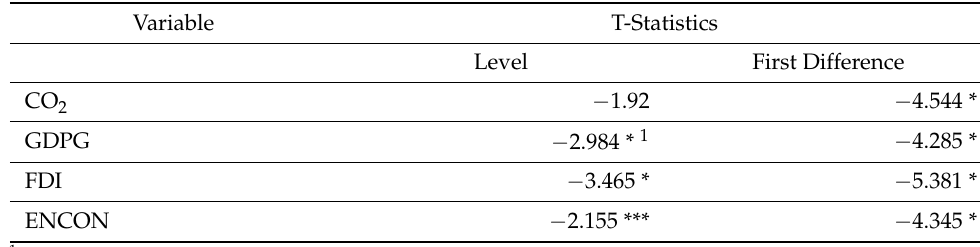
Table 4. Second-generation panel unit root tests